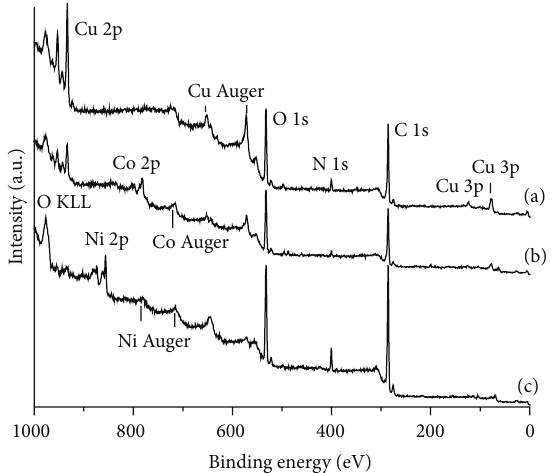
Figure 5: Survey XPS spectra of the homometallic and het- erometallic compounds. (a) [Cu 3 ( S,S (+)cpse) 3 (H 2 O) 3 ] ⋅ 8H 2 O, (b) [Cu 2 Co( S,S (+)cpse) 3 (H 2 O) 3 ] ⋅ 4H 2 O ( 1 ), and (c) [Cu 2 Ni( S,S (+) ⋅ cpse) 3 (H 2 O) 3 ] ⋅ 10H 2 O ( 2